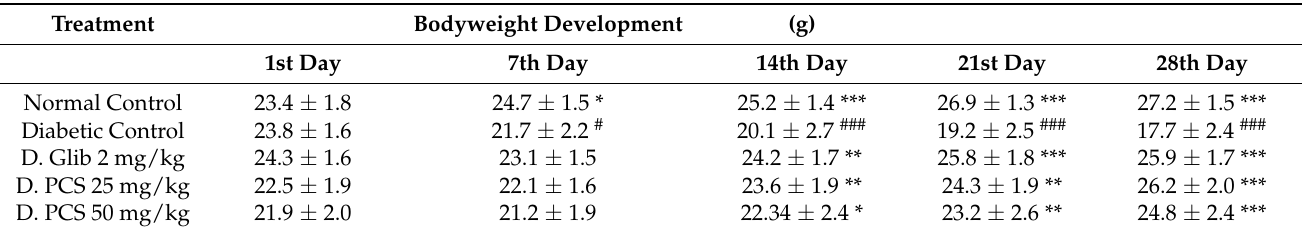
Table 2. Bodyweight changes of the experimental groups during the subacute period of 28 days. Treatment Bodyweight Development Normal Control